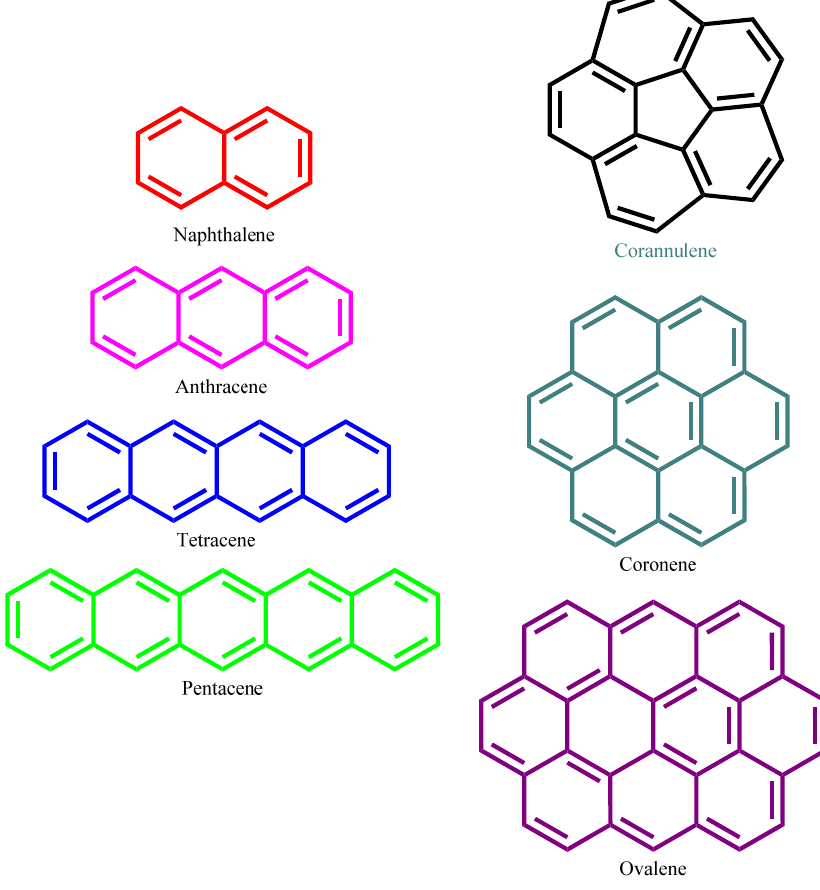
Figure 1. Structure of the selected PAH molecules for the adsorption